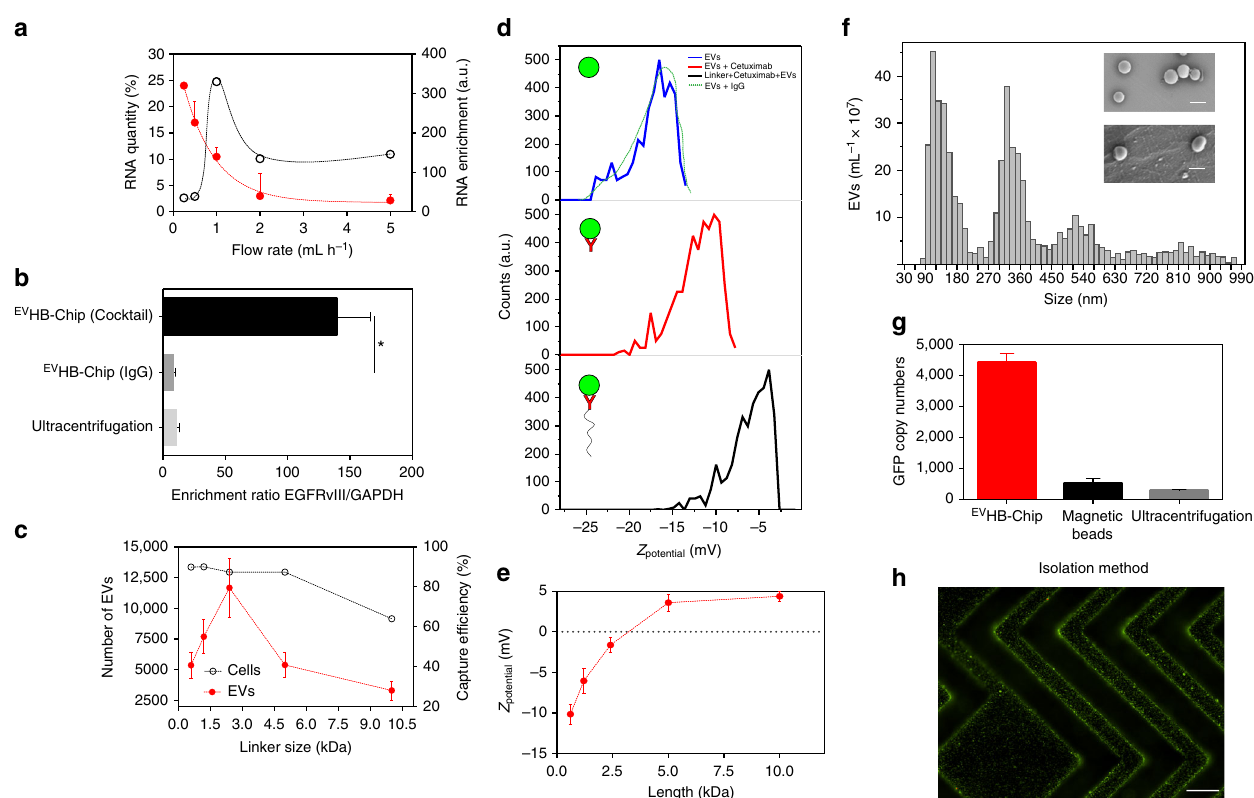
Fig. 2 Characterization and operation of the COC EV HB-Chip. a RT-PCR quanti fi cation of the RNA recovered from EVs captured on the micro fl uidic device coated with Cetuximab at different fl ow rates. RNA enrichment ratio in the micro fl uidic device was calculated between EGFRvIII and GAPDH and depicted by the dotted black line. The red line represents the total RNA quantity. b Comparison of RNA enrichment ratios between ultracentrifugation and different capture antibodies on the surface of the EV HB-Chip (* p < 0.05, one-way ANOVA). c Effect of linker size to captured tumor-speci fi c EVs and cells at 1 mLh − 1 . d Changes in Z potential distribution for different complex con fi gurations. EVs, EVs binded to antibodies, and EVs binded to linked antibodies. e Variation in Z fl uidic device. Different potential for different PEG linker size of the complex EV and antibodies. f Size and concentration of tumor EVs isolated with the micro size distributions were identi fi ed within the range of 40 – 1000 nm. Insert shows oncosomes (top, scale bar 2 μ m) and exosomes (bottom, scale bar 100 nm). g Performance comparison between the EV HB-Chip and standard EV isolation methods. Plasma from healthy donors with spiked-in fl uorescent EVs isolated from Gli36-EGFRvIII cells was run through the micro fl uidic device coated with Cetuximab to capture tumor EVs. In parallel, tumor EVs were isolated using magnetic beads coated with Cetuximab or by ultracentrifugation. ddPCR was used to quantify the total number of EGFRvIII copies captured with the different techniques. h Fluorescent microscopy image of immunoaf fi nity stained tumor-speci fi c EVs on the surface of a micro fl uidic chip (scale bar 50 μ m). For a , b , c , e , and g n = 3 technical replicates; ± s.e.m. For d and f , a representative experiment is shown from n = 3 technical